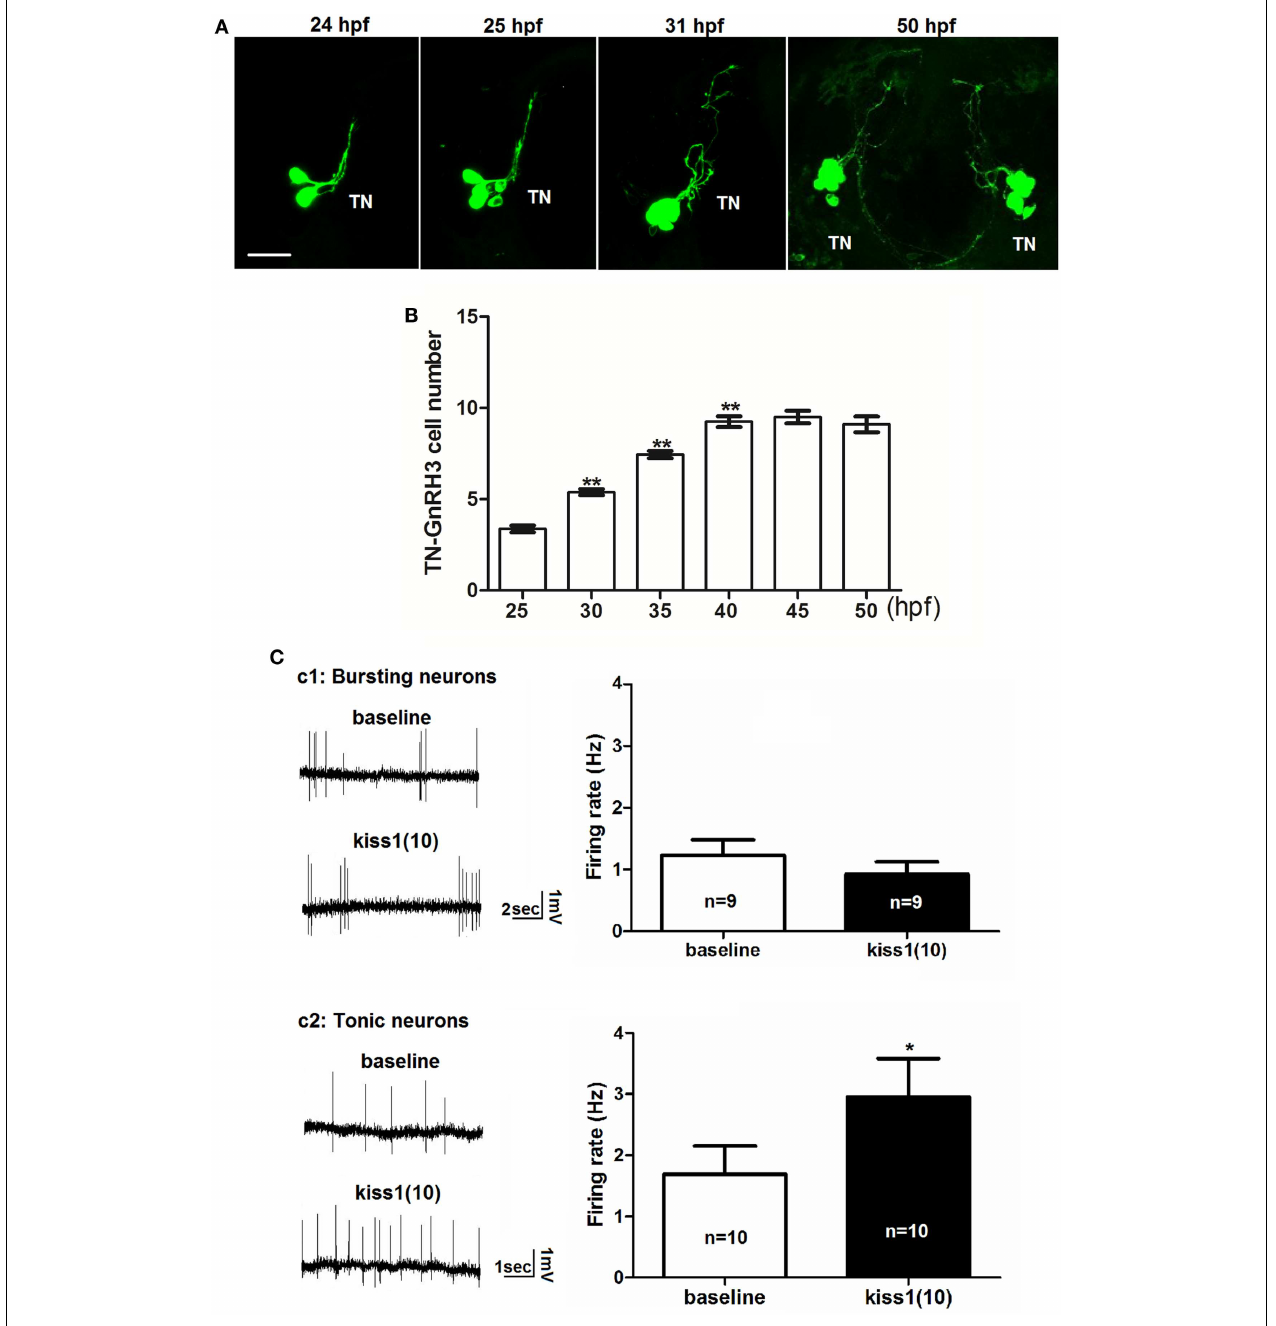
n = 10. (C) Loose-patch electrophysiological recording of spontaneous action potential firing ofTN-GnRH3 (2–3 dpf) neurons. Neurons were recorded under baseline control conditions followed by treatment with a 10-amino-acid fragment of kisspeptin1. (C1) Immature bursting neuron; (C2) : mature tonically firing neuron. * p < 0.05 (3C2); ** p < 0.001 compared to the previous time point (B)